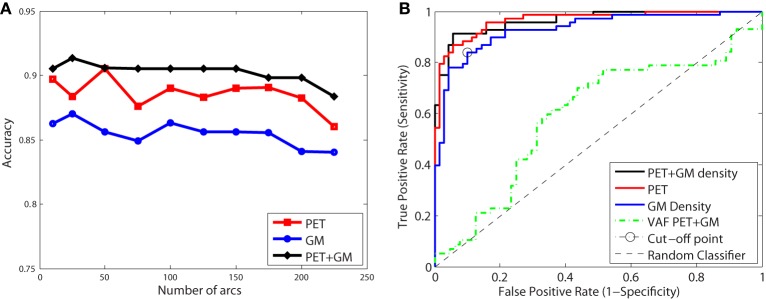
Accuracy (A) and ROC curve (B) for CN/AD classification considering a different number of arcs in the SICE.